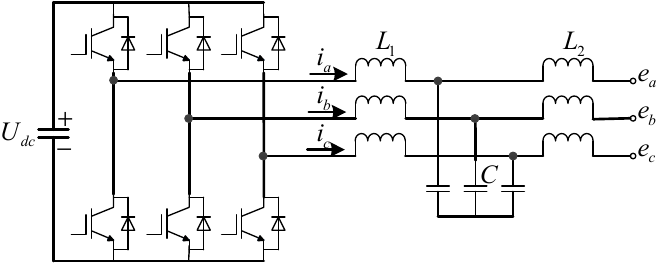
Figure 1. Schematic diagram of the three-phase three-leg grid-connected inverter.